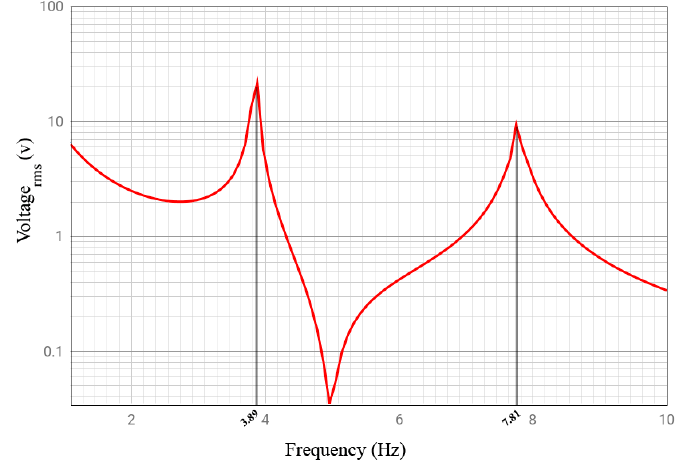
Figure 5. Voltage (log scale) against frequency response of MRPEH obtained from FEA under 0.2 g base excitation.